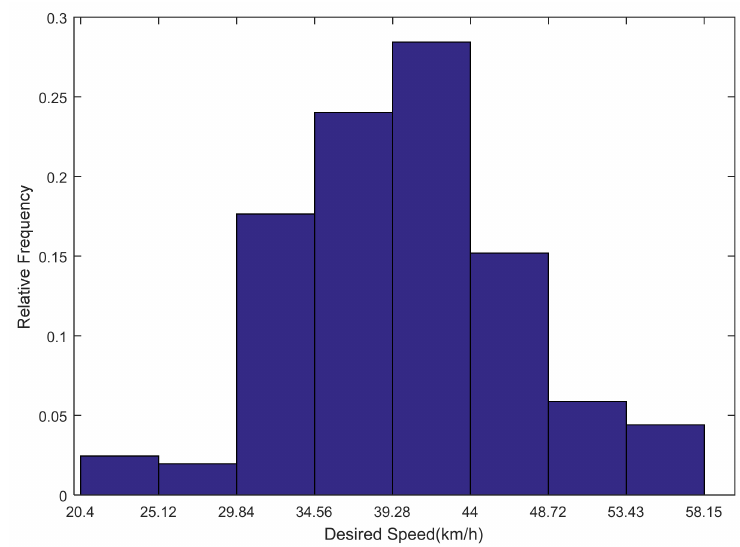
Figure 6. Histogram for the desired speed distribution of passenger